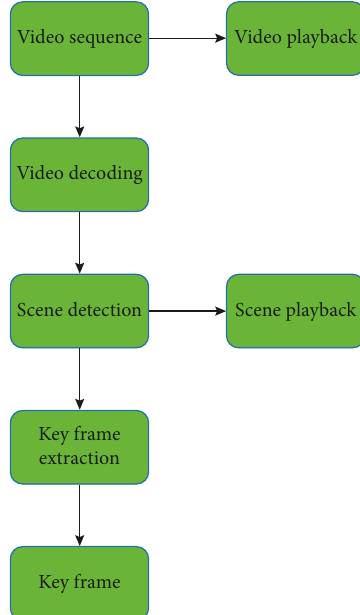
Figure 5: Key frame extraction subsystem structure diagram.